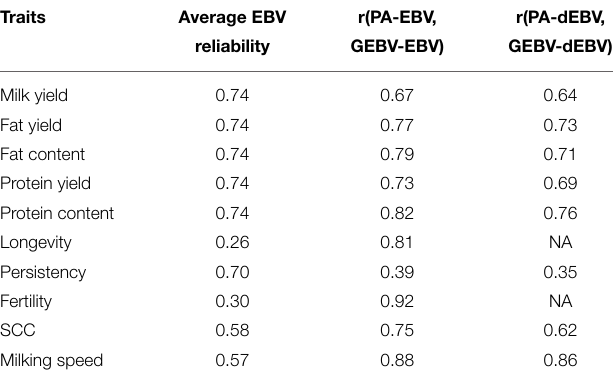
TABLE 3 | Average reliabilities of validation animals and correlations between parent averages based on EBV and GEBV/PA based on dEBV and